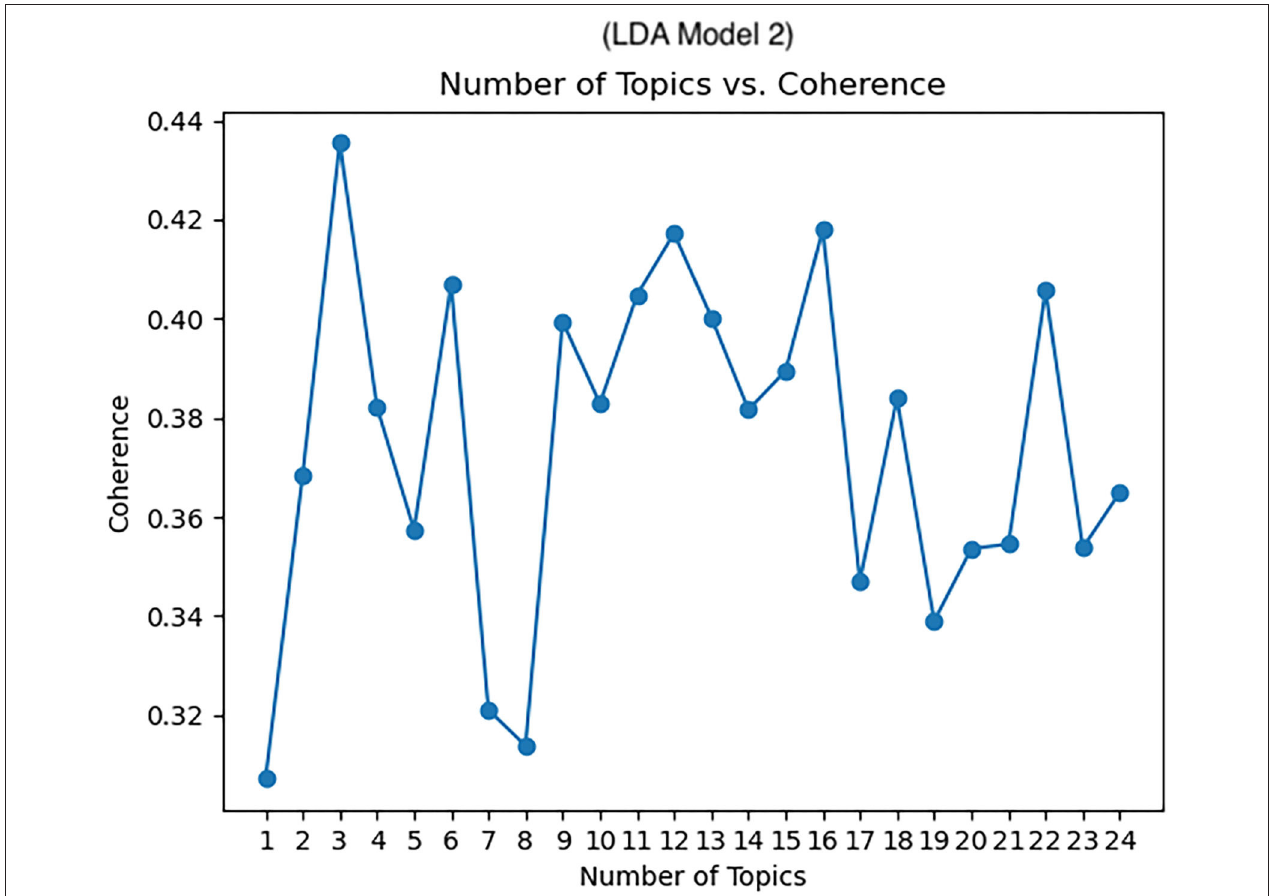
FIGURE 3 | The evaluation results showing the optimal number of topics for highest coherence score for the LDA Model after 250 passes.